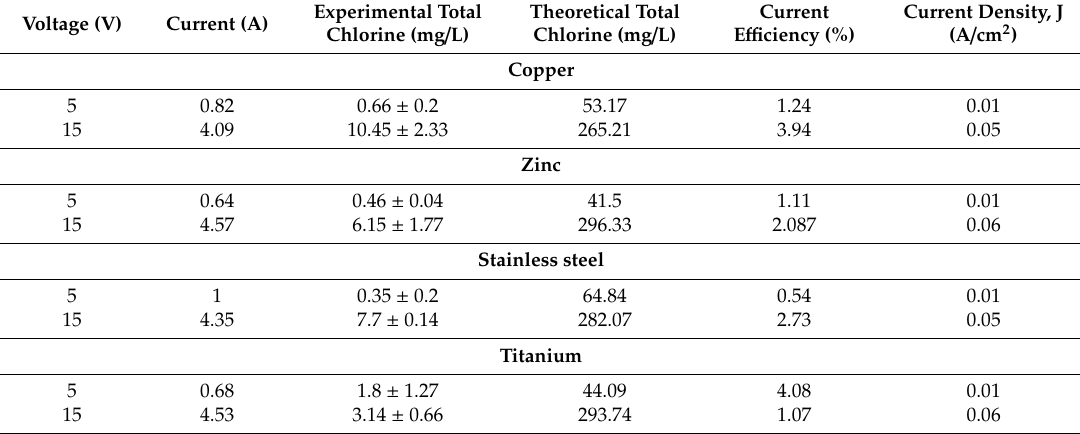
Table 3. Current e ffi ciency for di ff erent electrodes at 1 wt.% NaCl and 7.5 min electrolysis